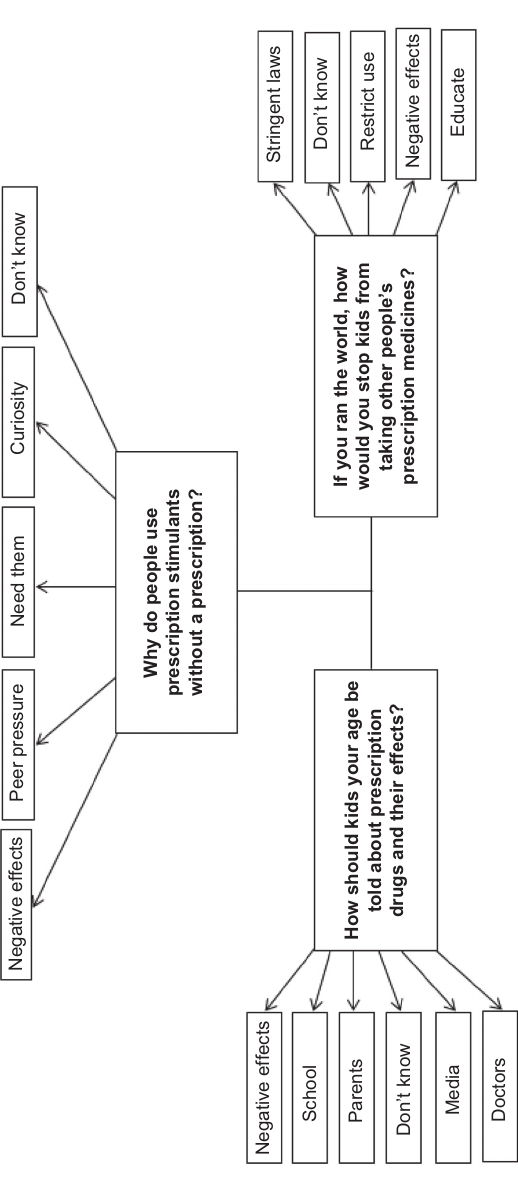
Figure 1. Diagram representing the themes that emerged for each of three qualitative